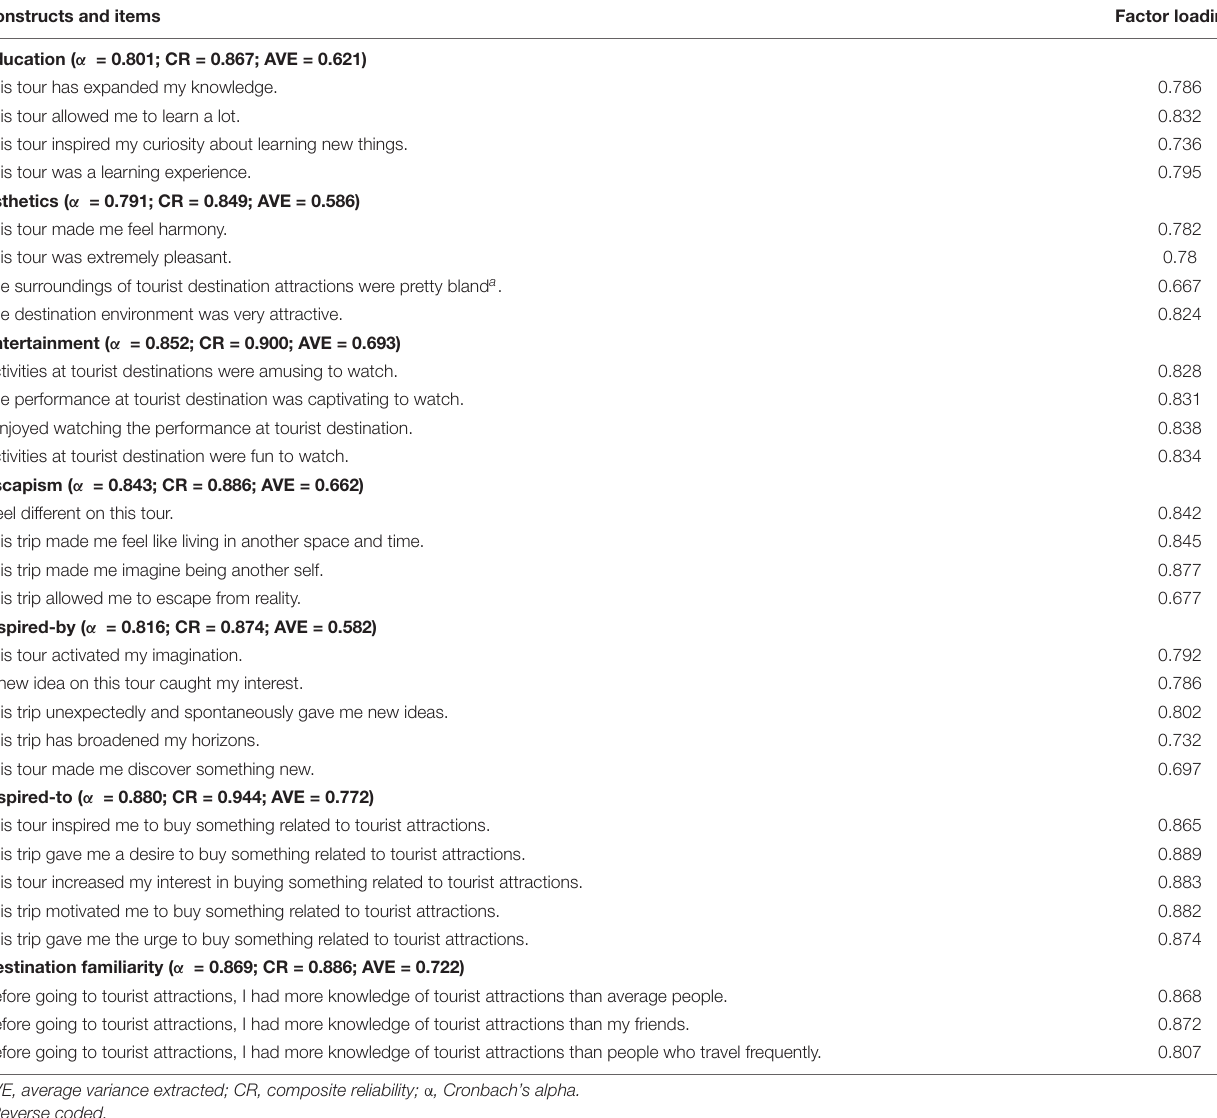
TABLE 2 | Measurement model results. Constructs and items Factor loadings